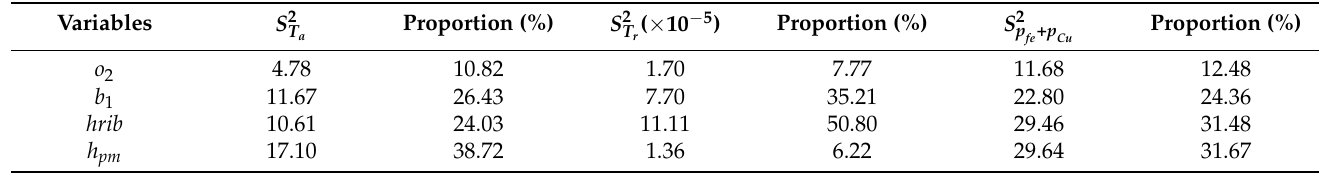
Table 9. Design variables for the initial and optimized